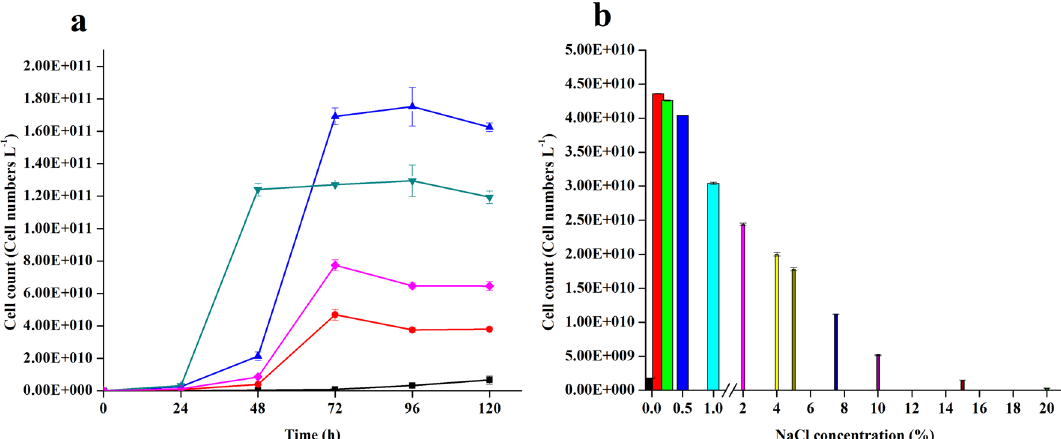
Figure 4. Effect of temperature and salt on growth of NCIM 3590. ( a ) Effect of temperature on the growth of NCIM 3590. The yeast was grown on YNBG at different temperatures for 120 h. Temperature symbols—10 °C (black filled square), 15 °C (red filled circle), 20 °C (blue triangle), 25 °C (dark cyan inverted triangle), 28 °C (magenta filled square). Data points are mean values from triplicate experiments with their standard deviation. ( b ) Effect of sodium chloride concentration on growth of NCIM 3590. Salt legends – 0.0% (black filled square), 0.1 (red filled square), 0.25% (green filled square), 0.5% (blue filled square), 1% (cyan filled square), 2% (magenta filled square), 4% (yellow filled square), 5% (dark yellow filled square), 7.5% (navy filled square), 10.0% (purple filled square), 15.0% (wine filled square), 20.0% (olive filled square). All experiments were carried out in duplicates and the mean values were recorded and the standard deviations (n = 2) are indicated as error bars. Different coloured bar indicates different concentration of NaCl